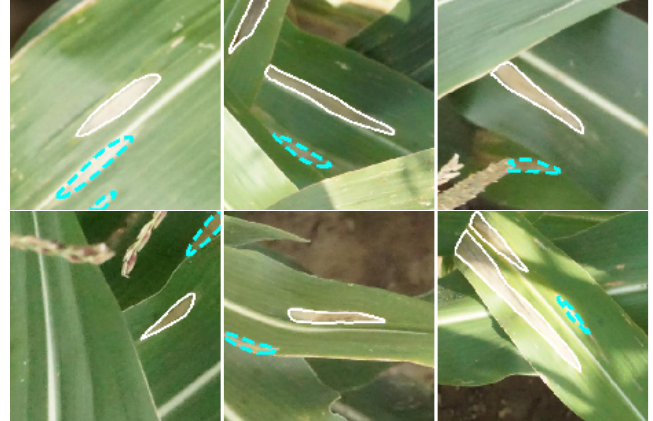
Figure 4. Predicted instances with missing ground truth (dashed cyan outline).